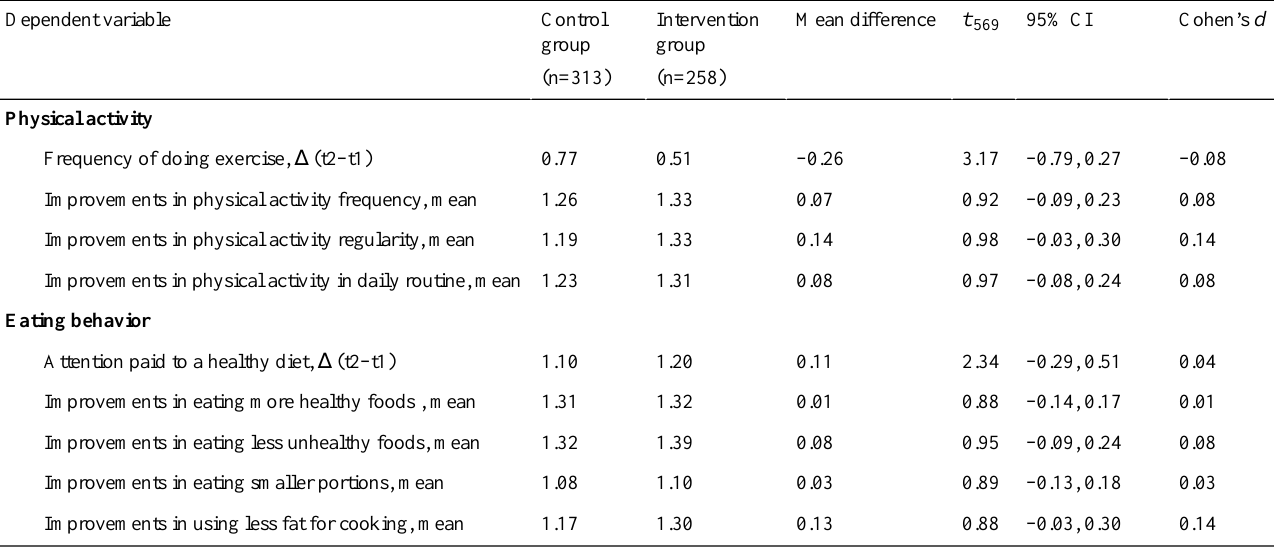
Table 2. Independent t tests—intention-to-treat